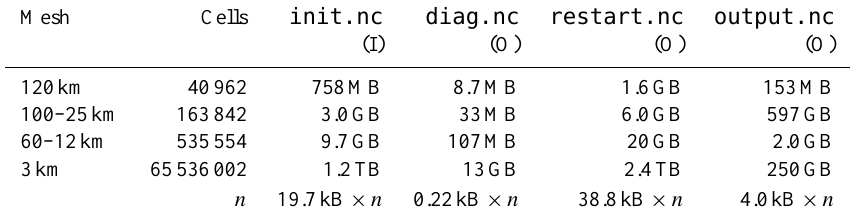
Table H1. File sizes of input (I) and output (O) files for all meshes (uncompressed netCDF3/4). For a given mesh with n grid cells, an estimate